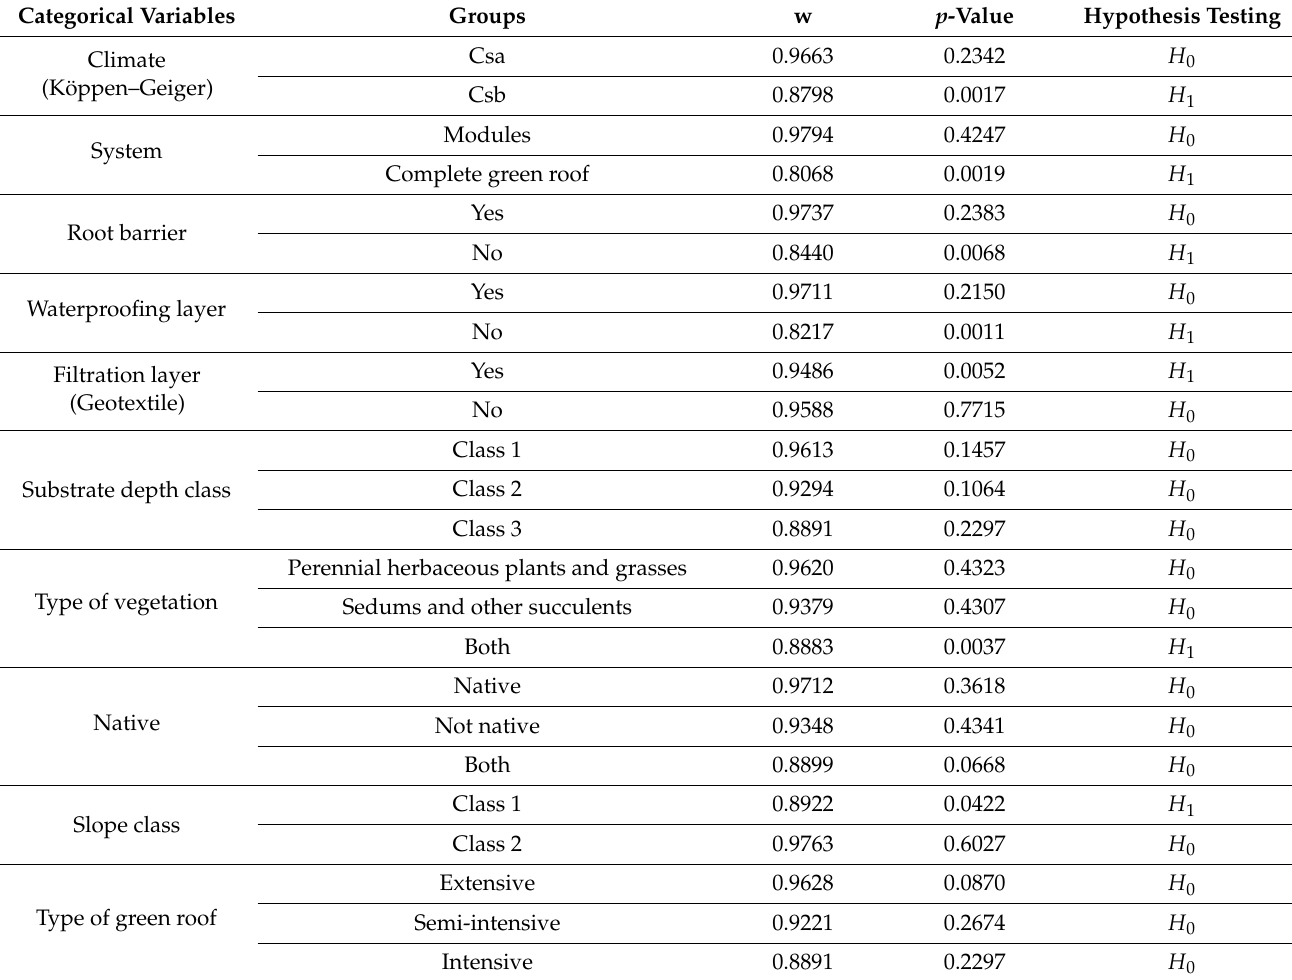
Table A2. Shapiro –Wilk test results for rainfall retention